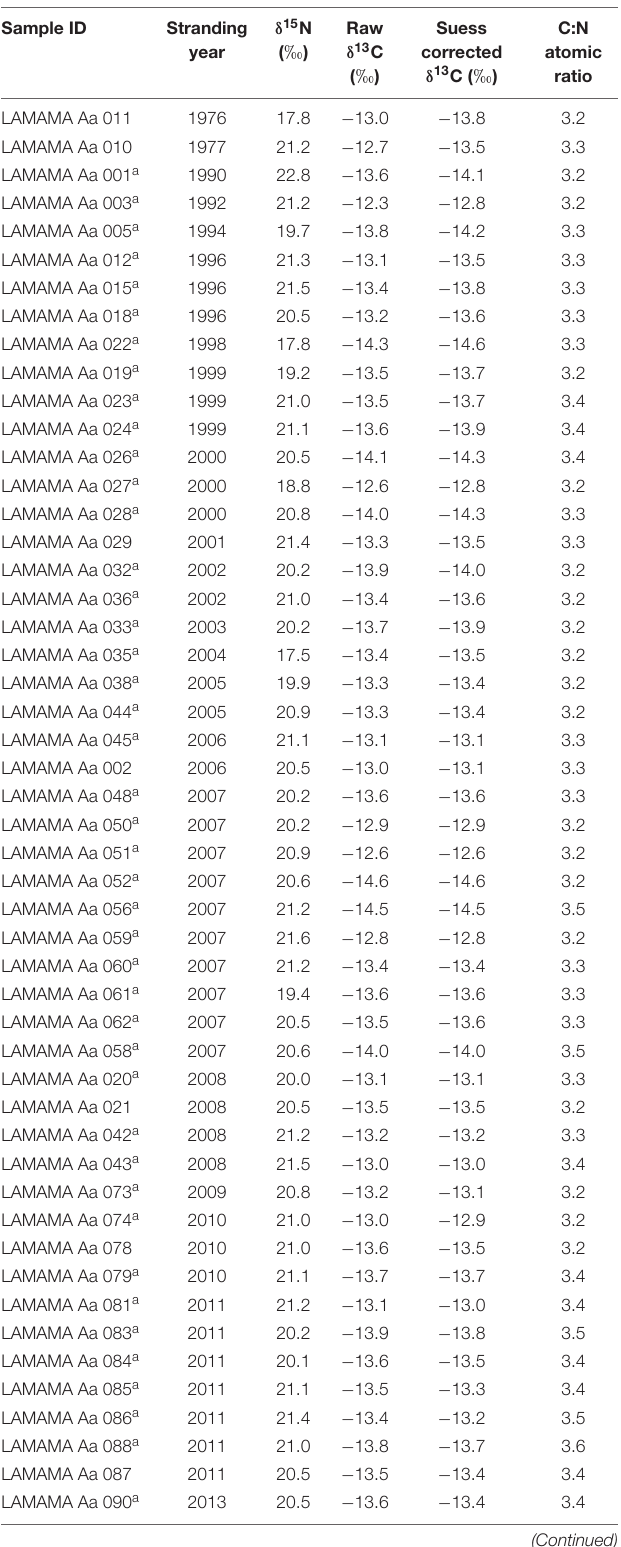
TABLE 2 | Stable isotope ratios ( δ 15 N, raw δ 13 C, and Suess corrected δ 13 C) in bone collagen of subadult and adult male South American fur seals dead stranded during the period 1976–2017 in northern and central